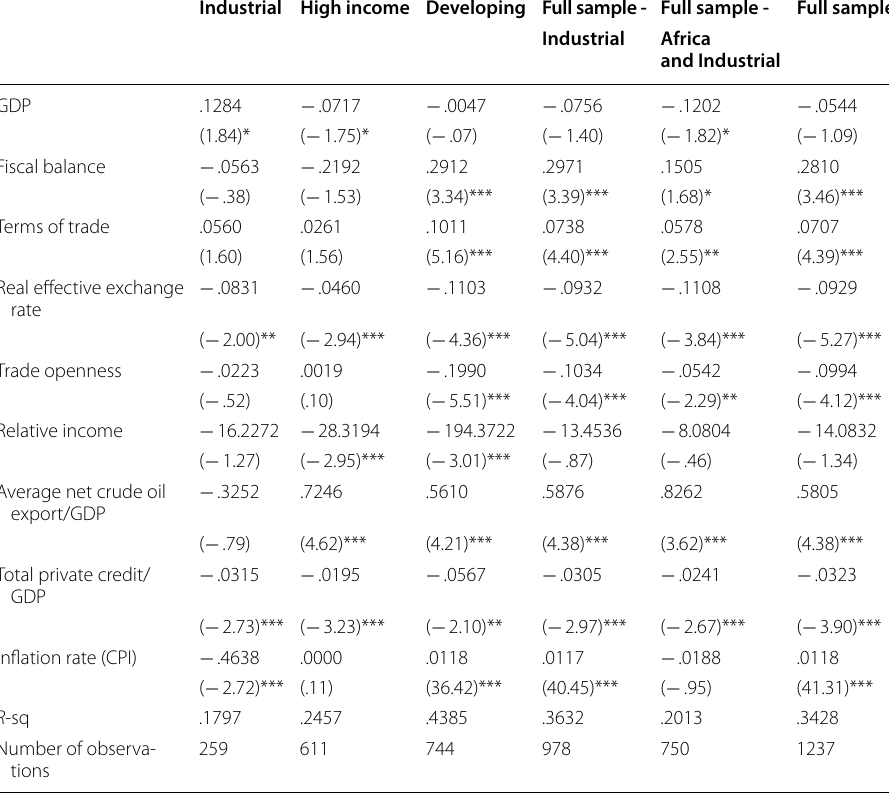
All variables are used in their first differences. t -statistics in parenthesis. *, **, *** indicate significance at 10%, 5%, 1%, respectively. The estimates for the constants are not